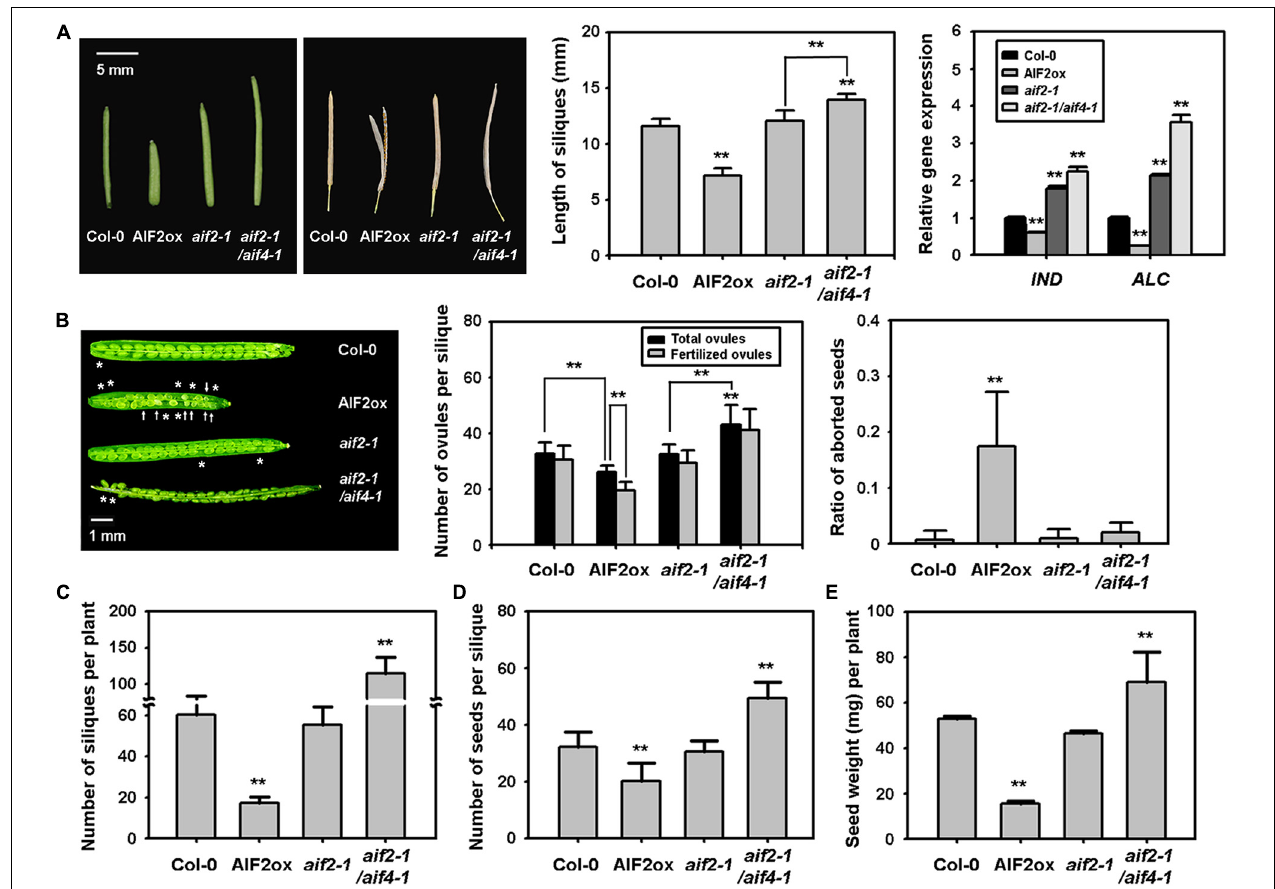
FIGURE 1 | Defective silique phenotypes of AIF2 -overexpressing p35S:AIF2-EGFP transgenic plants (AIF2ox). (A) Silique with shorter and premature dehiscence phenotypes. The picture on the left shows representative shorter and unfused gynoecia silique phenotypes. Siliques from opened flowers were measured for their length (middle) and transcript expression of genes involved in valve margin development of the carpel (right). Relative expression of each gene is normalised as a ratio of the Col-0 plants, which was set to 1. (B) Reduced ovule development and aborted seeds. The picture on the left shows regions lacking ovule development (*) and aborted fertilised eggs (arrow). Total ovules presented in the middle are calculated by the sum of visibly developed ovules and invisible empty ovule area. Fertilised ovules indicate the visible ovules. The ratio of aborted seeds on the right represents the ratio of seeds with defective phenotype (such as smaller or white) to total visible seeds. (C–E) Number of siliques (C) , seeds (D) , and total seed weight (E) was measured from more than 100 siliques collected from 30–40 plants. Bar graphs represent means ± SD and statistical difference from either the Col-0 control or bracketed samples is indicated by two asterisks (**) at P <